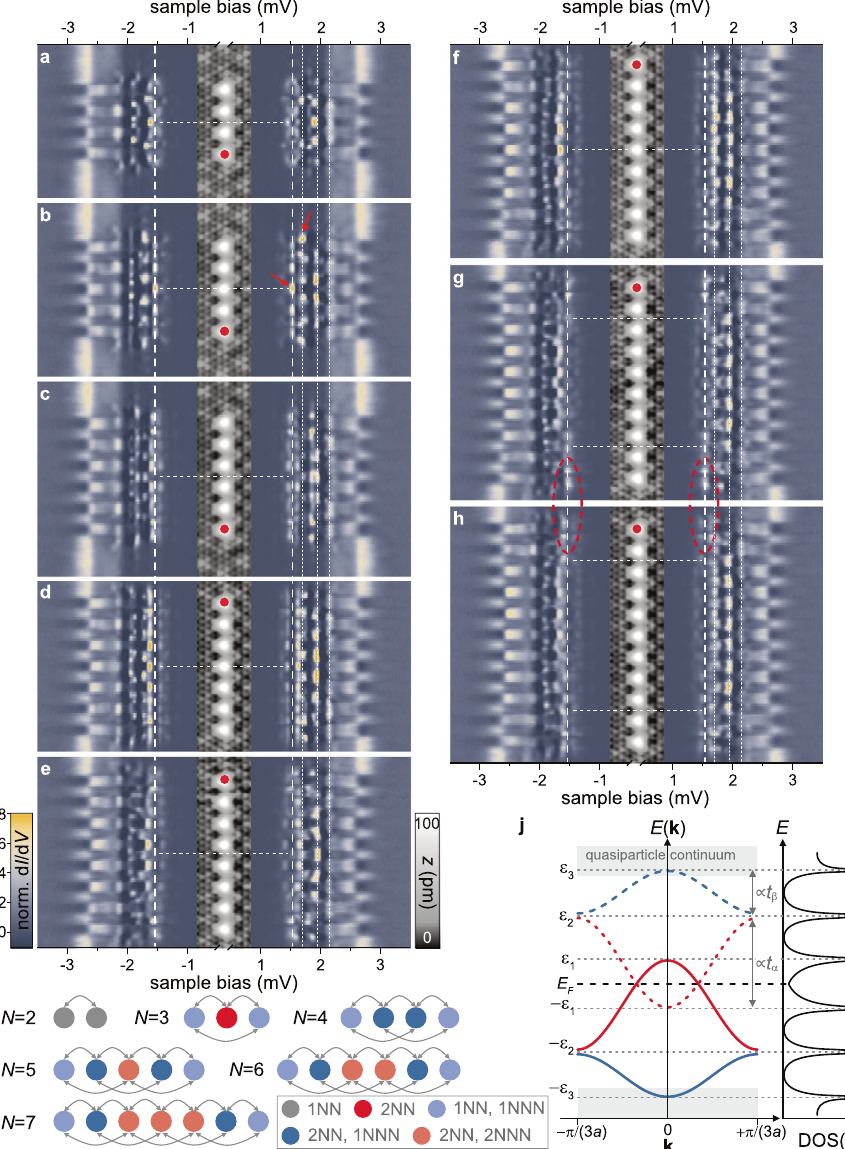
Fig. 4 Evolution of YSR bands in Fe atom chains. a – h Stacked constant-height d I /d V spectra (normalized) recorded along lines across chains containing 4 – 11 atoms as illustrated in the inset topographies (constant-current mode with set point 100 pA, 10 mV). Set point for spectra 250 – 700 pA, 5 mV with a modulation of 15 μ V. Vertical dashed and dotted lines indicate Δ tip ≈ ±1.55 meV and 2.15, 1.95, and 1.7 mV corresponding to energies of 0.6, 0.4, and 0.15 meV, respectively. These energies mark the van Hove singularities of the α and β derived bands (only at positive bias for clarity), see text. The bands originating from the γ and δ states are located within the coherence peaks and contribute to the modulations along the chain at higher biases. Horizontal dashed lines in a – f indicate mirror symmetry axes perpendicular to the chain. Horizontal dashed lines in g , h delimit the homogeneously appearing bulk of the chain. The states at the chain ’ s termination are marked by a red ellipse. Red dots mark the atom, that is added to the chain. Red arrows in b mark the large intensity at the center of the chain (left) and at the chain ’ s termination (right), see text. i Schematic illustration of the number of (next) nearest (N) NN neighbors for different atoms in chains with different lengths. j Schematic illustration of band formation and DOS with van Hove singularities at band edges. ± ε 1,2,3 correspond to the three pairs of dotted lines in a – h . The solid (dashed) lines represent the dispersion of the electron-like (hole-like) bands of the α (red) and β (blue)